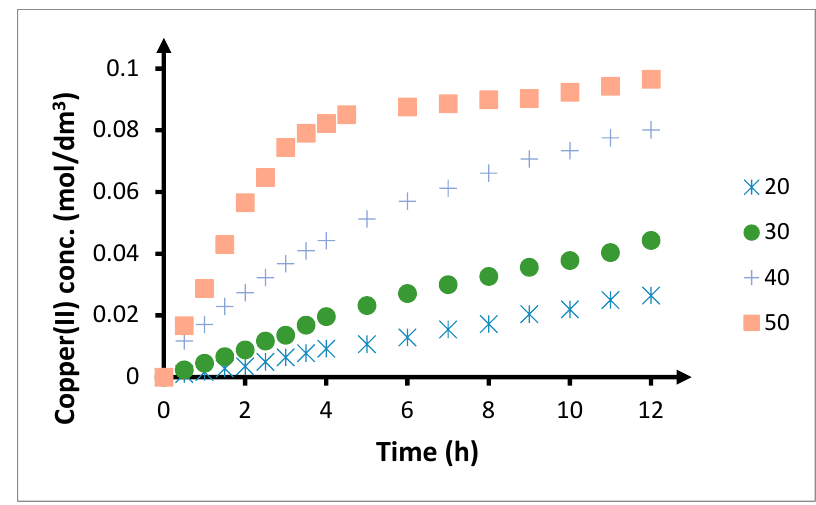
Figure 11. Influence of temperature on the transfer of copper(II) ions by PIM. The volumetric flow rate is 3.0 cm 3 /min. Feeding phase: CuCl 2 concentration—0.1 mol/dm 3 , chloride concentration—2.0 mol/dm 3 . Receiving phase: demineralized water. Membrane: CTA-ONPOE-TRIA-10. The composition of the membrane is provided in Table 2. Table 7. Recovery coefficient (R, %) of Cu(II) ions after 6 h and 12 h depending on the temperature. Temperature (°C)